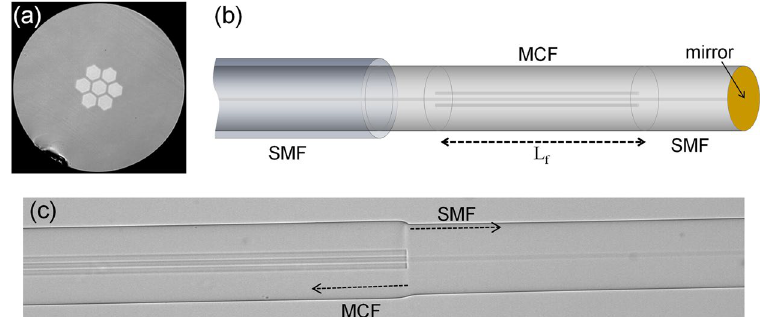
Figure 1. ( a ) Micrograph of the cross section of the MCF used to build strain sensors. ( b ) Sketch of a MCF interferometer. L f is the length of the MCF. ( c ) Micrograph of one the MCF-SMF